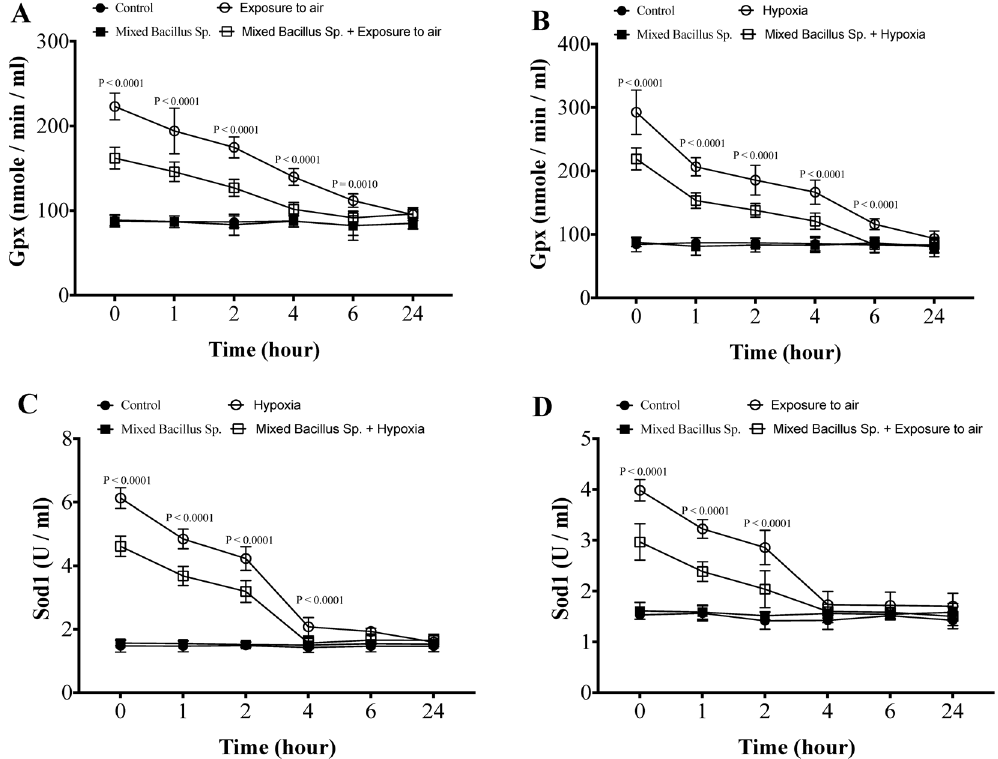
Figure 6. A mixed Bacillus Species lessens the plasma glutathione peroxidase (Gpx) and superoxide dismutase (Sod1). Yellow Perch response to hypoxia and air exposure stress over 24 h as reflected in plasma ( A , B ) Gpx and ( C , D ) Sod1 levels that were quantified using ELISA. Sample size = 9/group. Two-way Repeated measure ANOVA followed by comparing mixed Bacillus spp + stressed group to stressed groups was applied at two-tail significance level (P < 0.05). Data represented in mean ±